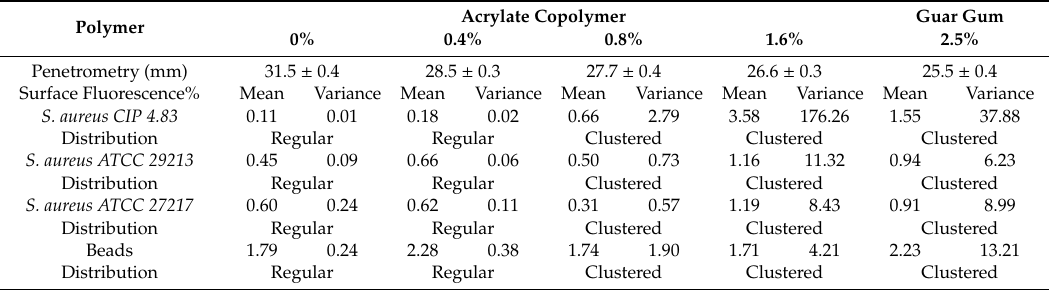
Table 1. Mean and variance associated to frequency distribution of surface fluorescence ( n = 3375 images) of three S. aureus strains and hydrophilic beads in matrices with various concentrations of acrylate copolymer (from 0% to 1.6%) or guar gum (2.5%); distribution is regular if variance < mean and clustered if variance >